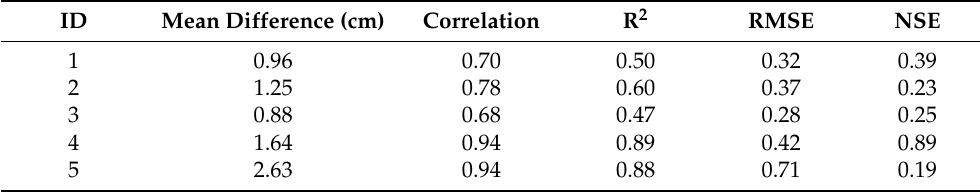
Table 2. Parameters that indicate the accuracy of the simulation model by study plots.